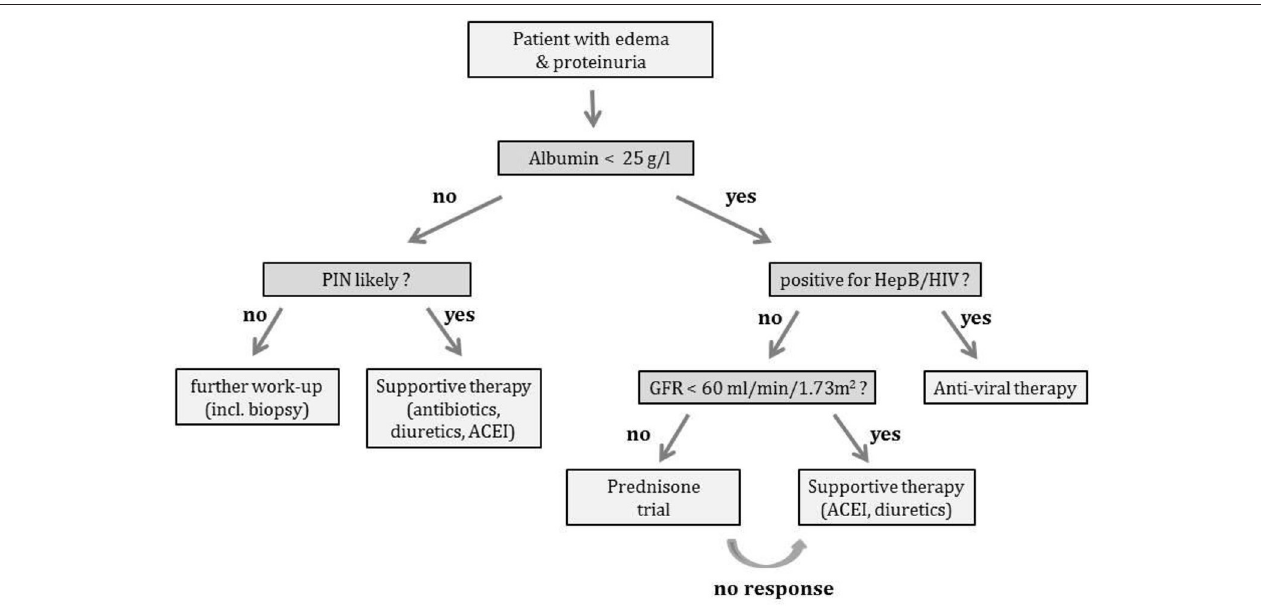
FIGURE 3 | Work-up algorithm. Work-up of patients with proteinuria (* a prednisone trial, if a RPGN seems unlikely; supportive therapy includes diuretics, antibiotics, anti-hypertensives and anti-proteinuric medication with angiotensin converting enzyme inhibitors).